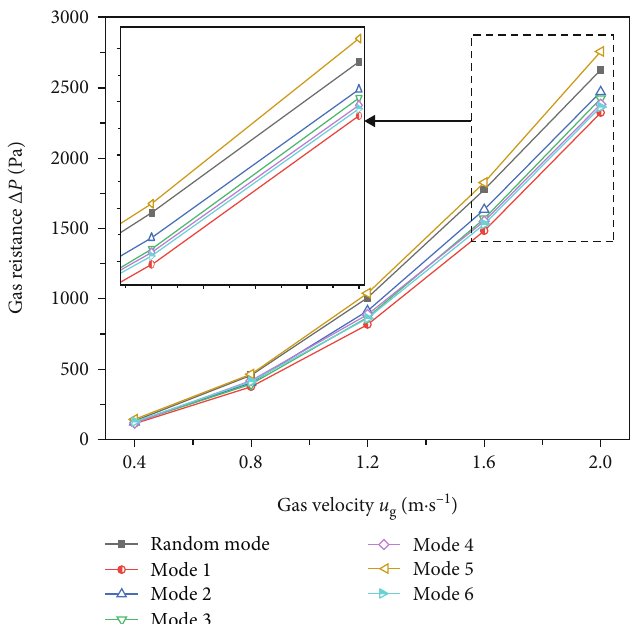
Figure 8: The change of the gas resistance Δ P with the gas velocity u distribution mode for the sinter mixture with the equivalent particle diameter of 11.45mm.